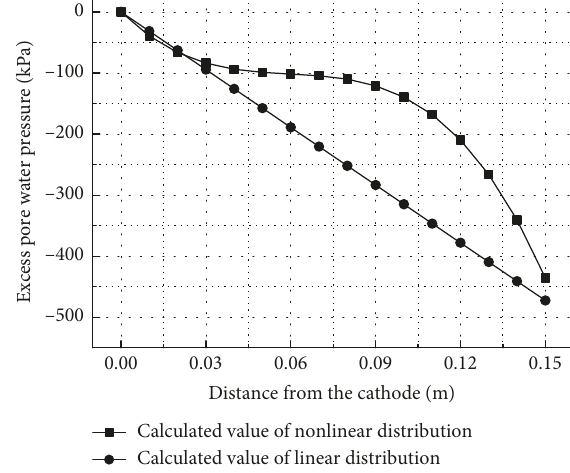
Figure 10: Distribution of excess pore water pressure based on the Lefebvre test data ( t �